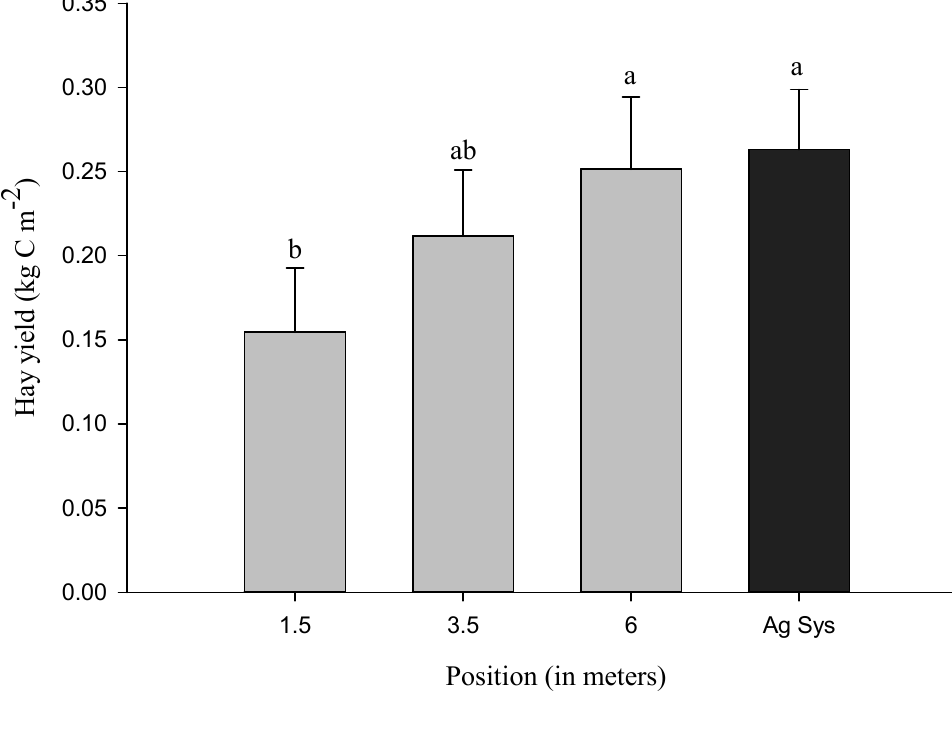
Figure 3. Hay yield (kg C m − 2 ) at sampling positions located 1.5, 3.5 and 6 m from the tree row (pooled amongst the poplar and hardwood trees) and in the center of the adjacent agricultural system (Ag Sys) at St. Paulin. The error bars are the standard deviation of the mean ( n = 6). Means with different letters are significantly different at p < 0.05 (Tukey